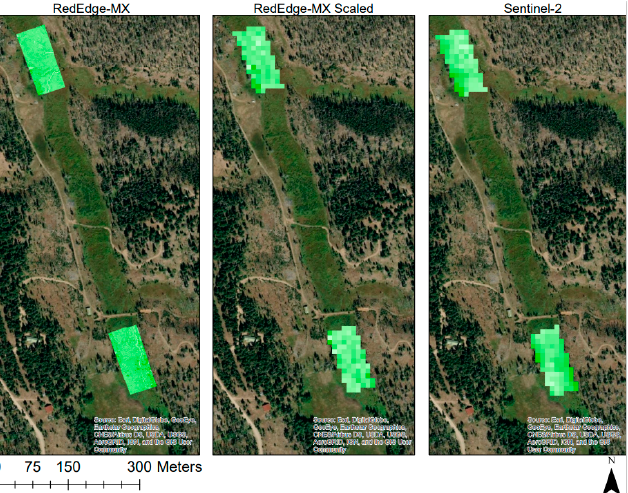
Figure 12. EVI raster images from Sentinel-2, RedEdge-MX dual camera system and scaled RedEdge-MX for treatment reach on 25 May 2020.